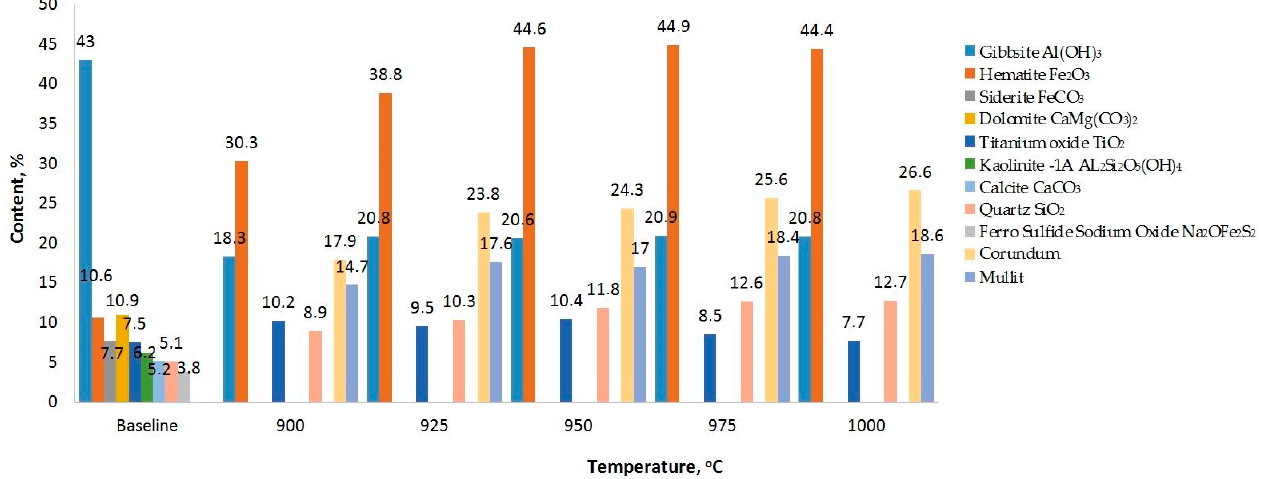
Figure 8. The phase composition of bauxite depending on the roasting temperature.